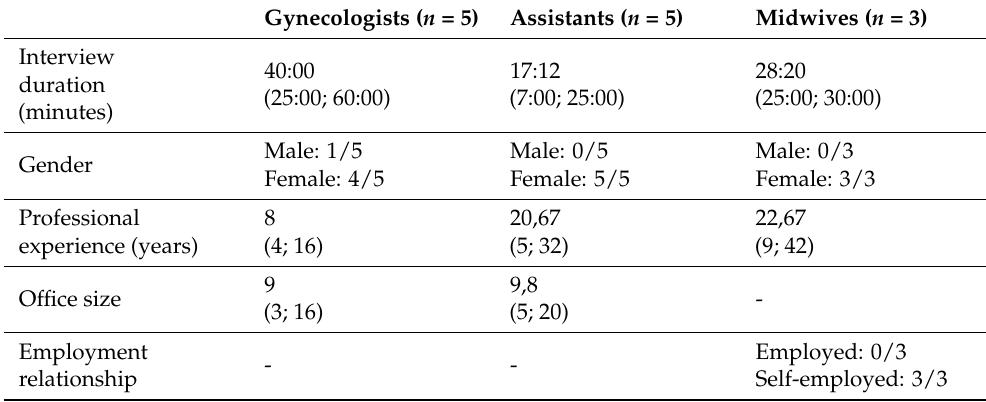
Table 2. Sample description of HCPs; mean values (minimum;